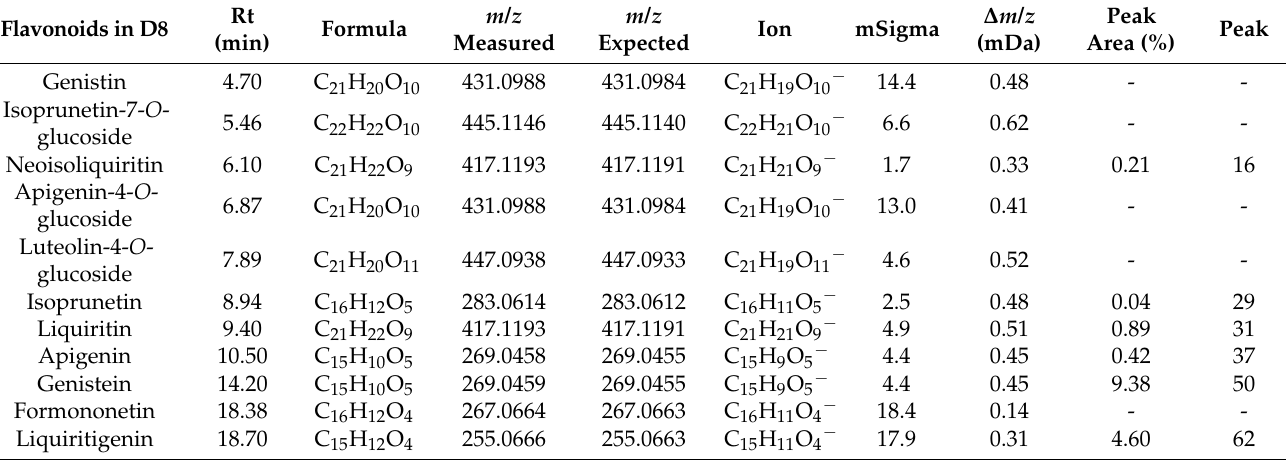
Table 4. Flavonoids identified in targeted analysis via UHPLC-ESI-QToF of sub-fraction D8 of U. gallii (Rt = retention time, m / z = mass/charge ratio of the compound, mSigma = deviation in the isotopic pattern, ∆ m / z = deviation in the mass ratio/charge measured in relation to the expected